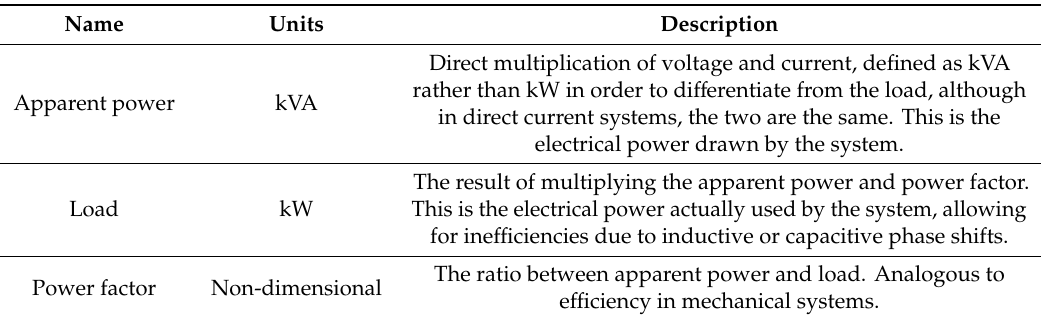
Table 2. Definition of electrical energy variables.